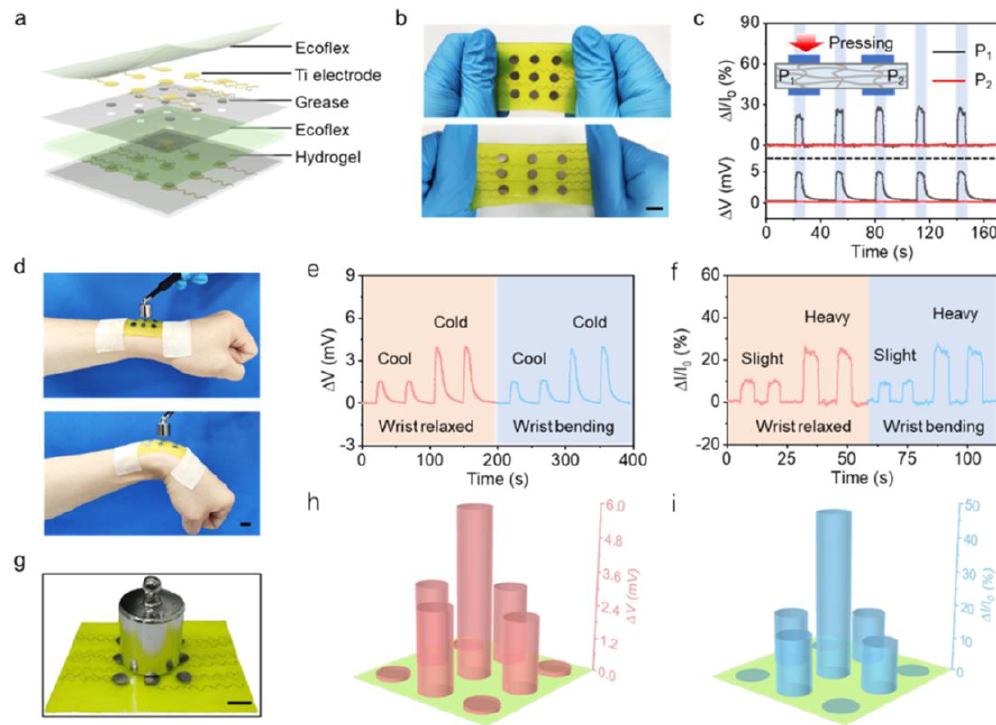
Figure 19. Design and performance of the TGH sensor array. ( a ) Schematic of a 3 × 3 pixel TGH sensor array. ( b ) Tensile properties of the TGH sensor array. ( c ) Response of output thermal voltage and relative current change of adjacent pixels on a TGH sensor array when one of them is pressed by a finger. ( d ) Photographs of the TGH sensor array as a secondary i-skin on the human wrist with relaxed and bending (strain: ∼ 25%) states. Output voltage ( e ) and relative current change ( f ) response curves generated by objects with different temperature and pressure. ( g ) Schematic of simultaneous measurement of temperature and pressure stimuli when a weight is placed in the center of a TGH sensor array. Output voltage ( h ) and relative current change ( i ) of the TGH sensor array in ( g ). All scale bars represent 1 cm. (Reproduced with permission from [124]. Copyright 2022 American Chemical Society).